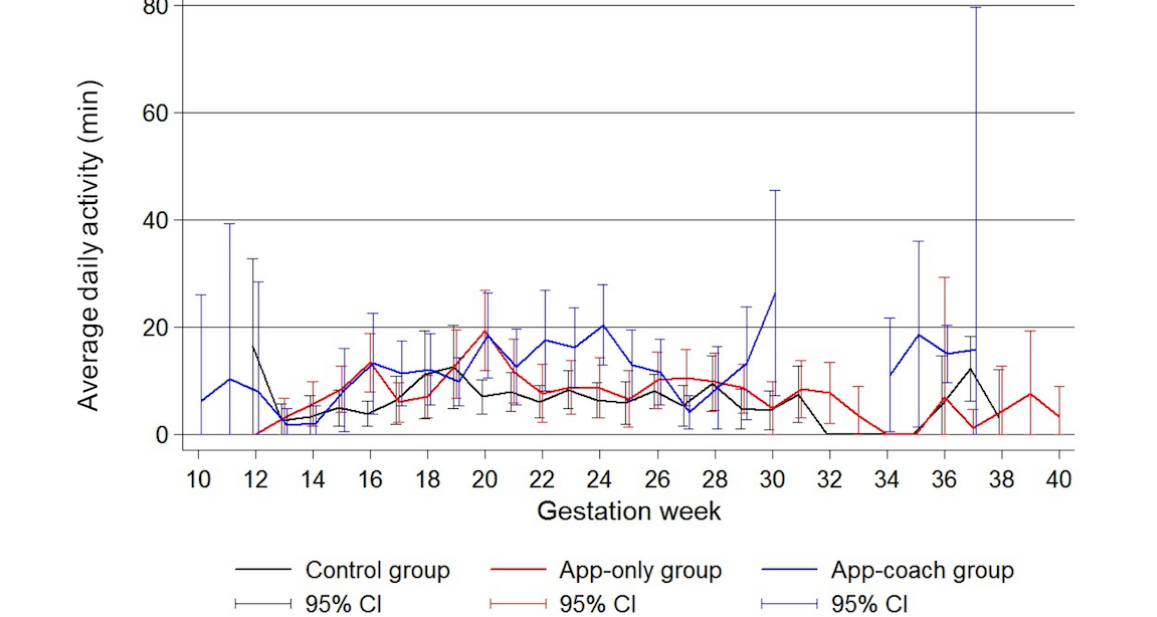
Table 3. Results of the statistical model investigating steps.